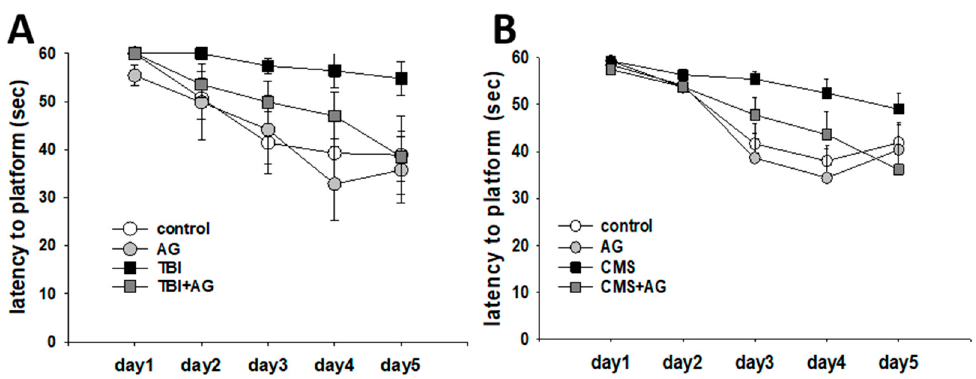
Figure 1. Spatial learning by Angelica gigas (AG) in traumatic brain injury (TBI) and chronic mild stress (CMS) mice as measured by the latency to the platform in the Morris water maze (MWM). ( A ) TBI model. There were repetitive training (within) effects [F(4,104) = 13.9, p < 0.001] and treatment group (between) effects [F(3,26) = 2.27, p = 0.044], but with non-significant within–between interaction differences [F(12,104) = 1.1, p = 0.36]. The post-hoc pairwise comparison showed a difference between control vs. TBI ( p = 0.033), TBI vs. TBI + AG ( p = 0.041). ( B ) CMS model. There were repetitive training effects [F(4,196) = 31.3, p < 0.001], treatment group effects [F(3,49) = 3.1, p = 0.034], and within–between interactions [F(12,196) = 2.2, p = 0.012]. Post-hoc pairwise comparison revealed a difference between the control and CMS groups ( p = 0.019), AG vs. CMS ( p = 0.01), CMS vs. CMS + AG ( p = 0.042). All data were normally distributed and are represented as means ± S.E.M. Control: vehicle (DW) treated; AG: Angelica gigas 1 mg/kg; TBI: vehicle treated + traumatic brain injury; TBI + AG: Angelica gigas 1 mg/kg + traumatic brain injury; CMS: vehicle treated + chronic mild stress; CMS + AG: Angelica gigas 1 mg/kg + chronic mild stress. Repeated measure ANOVA, Tukey’s HSD post-hoc test.